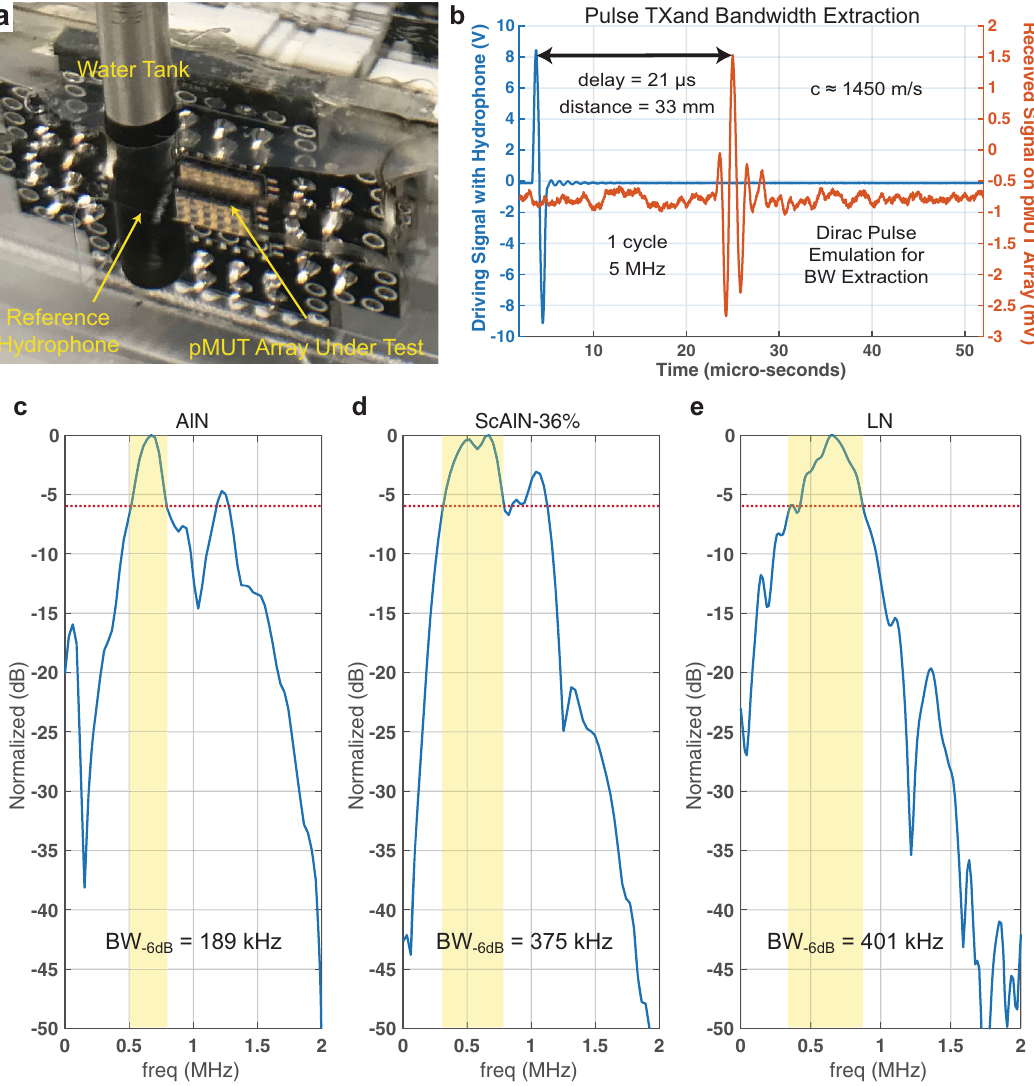
Fig. 8 Ultrasonic setup, bandwidth extraction, and comparison. a Measurement setup for ultrasonic transmission between a commercial hydrophone (Teledyne) and the LN pMUT array submerged in a De-Ionized (DI) water tank. b Dirac pulse transmission to extract the pMUT bandwidth (BW) with a Fast Fourier Transform (FFT). c BW of an AlN pMUT. d BW of a ScAlN-36% pMUT. e Bandwidth of the LN pMUT in this work, at the same frequency of AlN and ScAlN-based pMUTs for